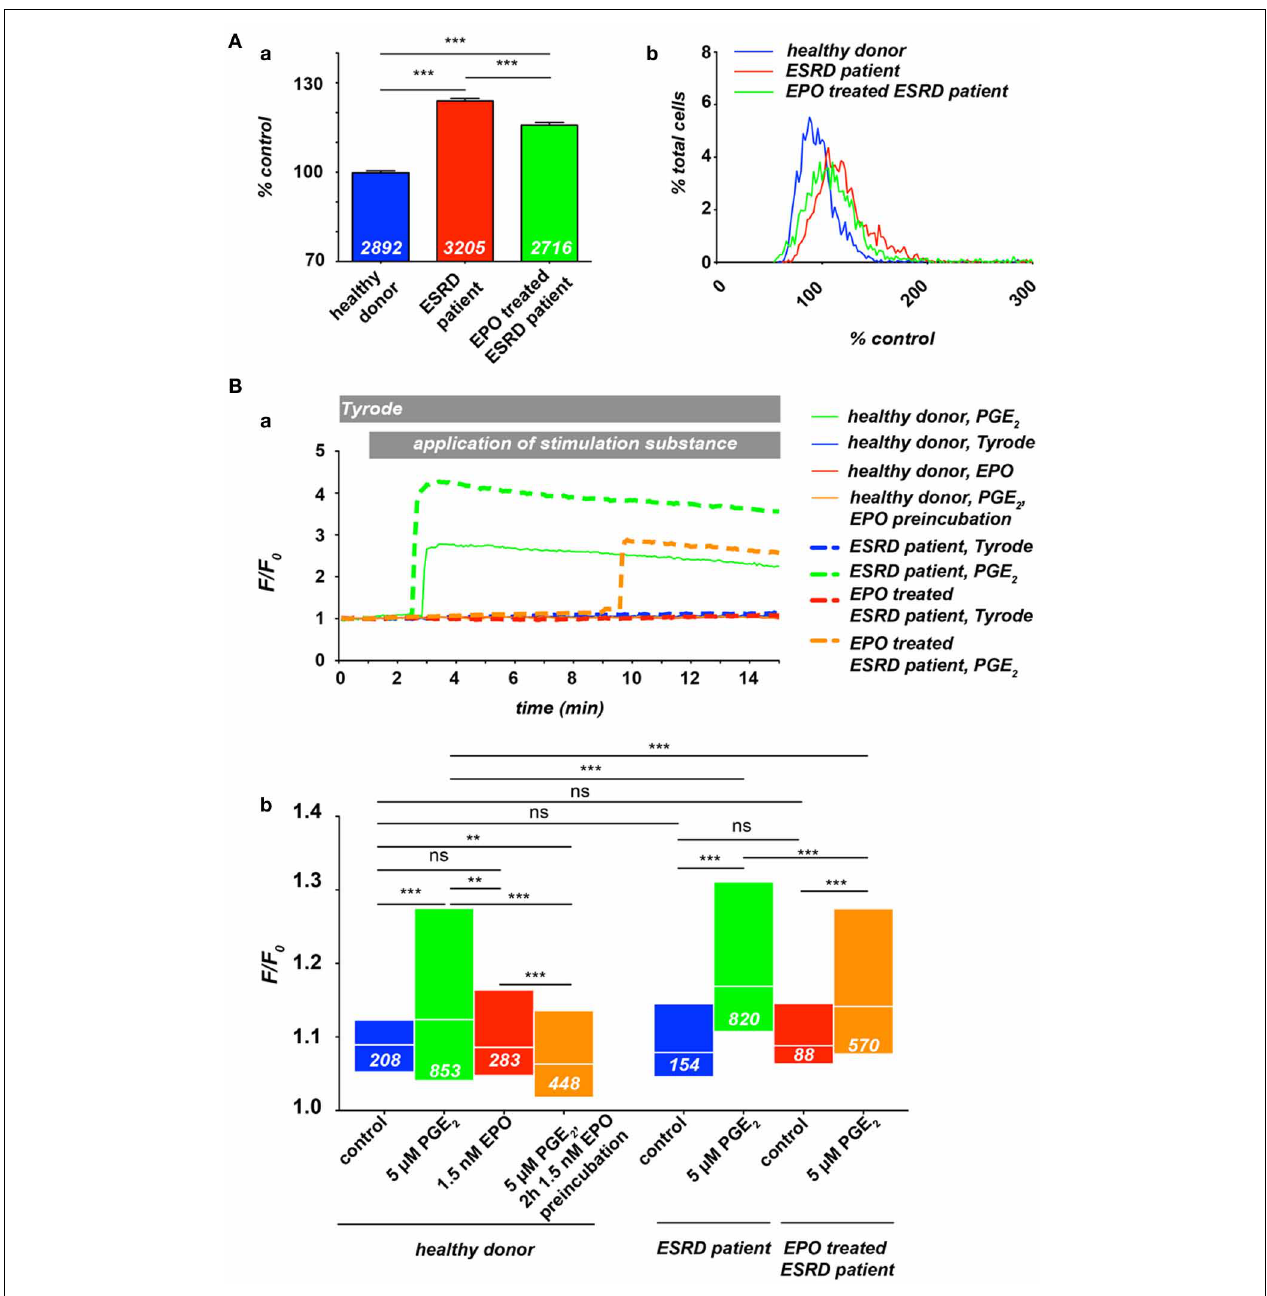
FIGURE 1 | Ca 2 + in RBCs of healthy donors and end-stage renal disease (ESRD) patients with a renal anaemia. If patients were under EPO treatment, the last EPO administration was within 5 days of blood sampling. All experimental procedures are previously described in detail (Wang et al., 2013). (A) Resting Ca 2 + in terms of relative Fluo-4 fluorescence intensity of RBCs suspended in plasma. (Aa) Statistical analysis of RBC Ca 2 + of at least 3 individuals in each group. The white numbers indicate the number of cells analyzed and the error bars represent standard error of mean. (Ab) Histograms of the relative fluorescence intensity distribution of the measurements presented in (Aa) . (B) Intracellular Ca 2 + -traces in RBCs under different conditions: control (Tyrode solution containing in mM: 135NaCl, 5.4KCl, 10 glucose, 1 MgCl 2 , 1.8 CaCl 2 and 10 HEPES; the pH was adjusted to 7.35 using